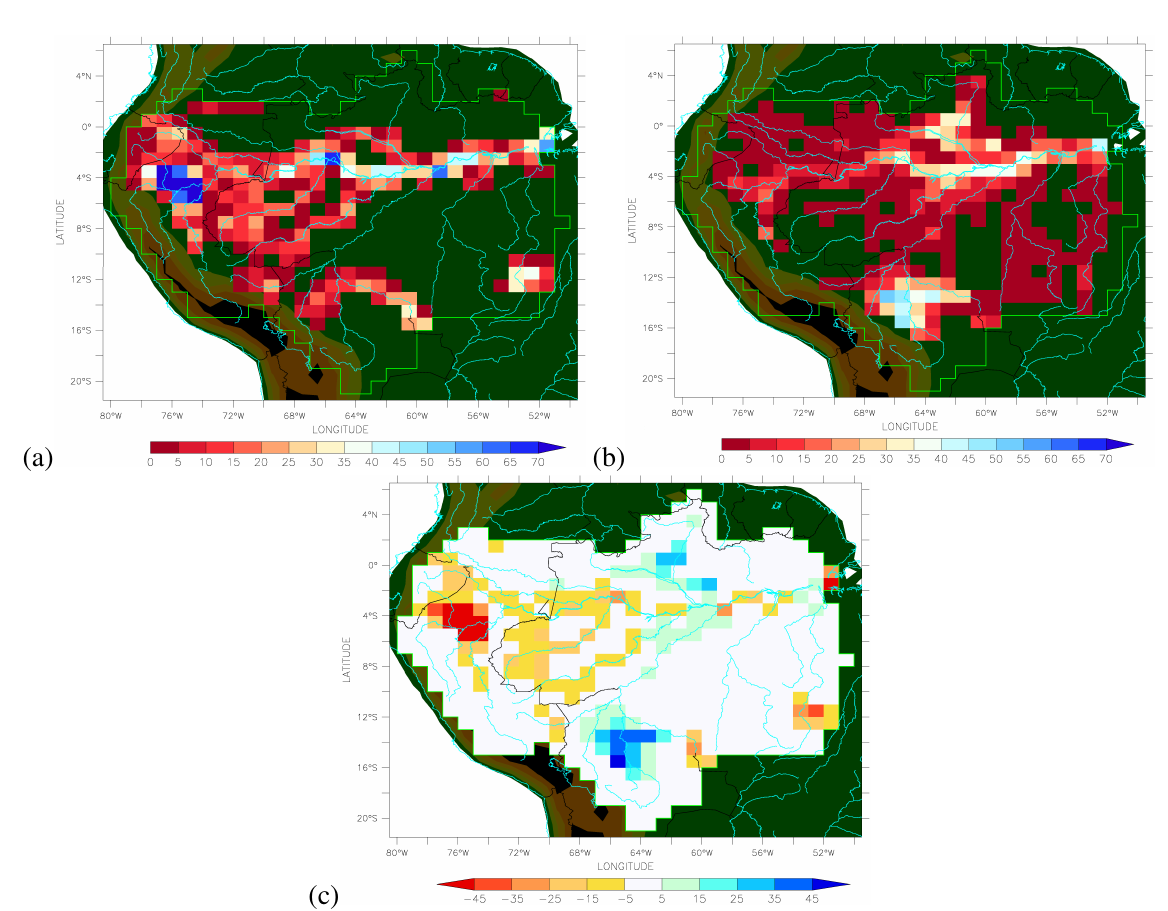
Fig. 5. Maximal fraction of swamps within the mesh (% of the mesh area) over the Amazon River basin from (a) GLWD and (b) PRIMA. (c) Differences between (b) and (a) . Dark green and brown colors indicate the topography of the region. For topographic scale, see Fig. 2.